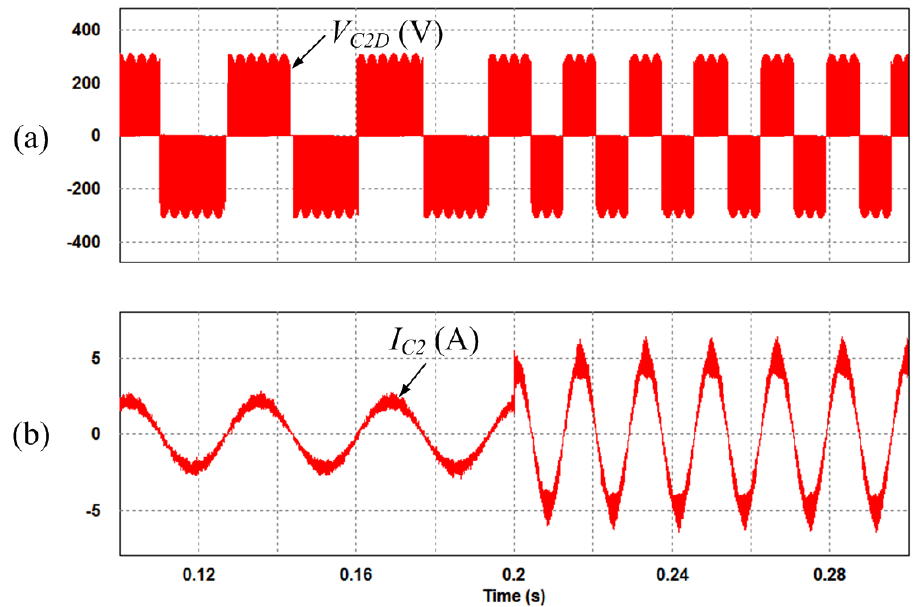
Figure 10. Simulation results of dynamic response for the single-phase load: ( a ) output line-to-line voltage; ( b ) single-phase output